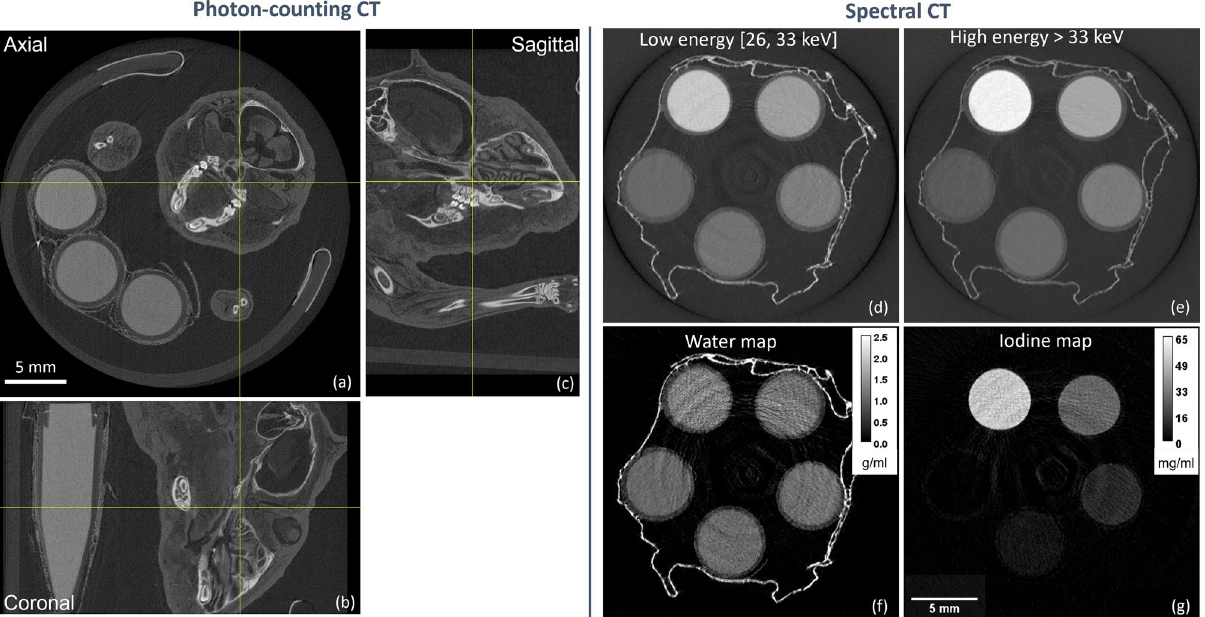
Figure 7. Axial ( a ), coronal ( b ), and sagittal ( c ) views of a plasticized mouse sample acquired in photon- counting CT mode; cuvettes filled with water-based solutions have been used for calibration purposes. In ( d – g ) a slice of an iodine-based sample acquired in XSI mode corresponding to the low ( d ) and high ( e ) energy bins and its material-based decomposition into water ( f ) and iodine ( g ) density